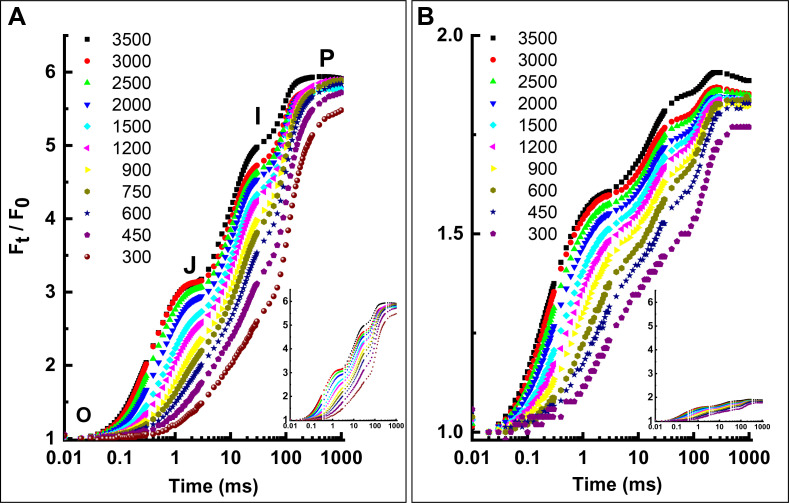
Light-intensity dependence (µE m−2 s−1 red light) of the OJIP transients of three types of tobacco leaves.(A) WT. (B) Asta. The insets show the same data but on comparable scales to illustrate the dramatic effect of the presence of astaxanthin on the variable fluorescence intensity. All transients have been normalized to F0. The F0 values of the leaves were approximately the same. The Asta mutant exhibits all the characteristic points of the OJIP curve, has a similar light dependence of the kinetics of PSII and shows comparable area above the normalized fluorescence traces. All these observations indicate that the function of PSII and the characteristics of the photosynthetic electron transport chain are largely similar to the WT. However, due to the light-harvesting differences between the WT and the mutant, quantitative comparison of these traces is impossible, as the functional antenna size is altered. Also, the quantity of PSII electron acceptors and the structure of thylakoid membranes were not measured in Asta plants, and both parameters will also influence the OJIP curves. The functional antenna size of PSII (Table 3 in the main text) was measured as the slope of the light intensity dependence of the 300 µs timepoint and normalized to the initial fluorescence value (F300µs/F0) .